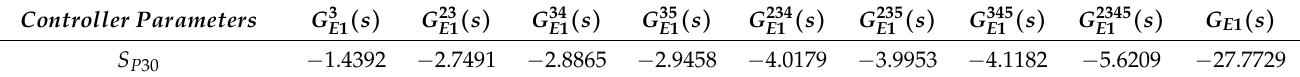
Table 5. The sensitivity of different paths of the en-stabilizing functions to the parameters of P 30 . Controller Parameters